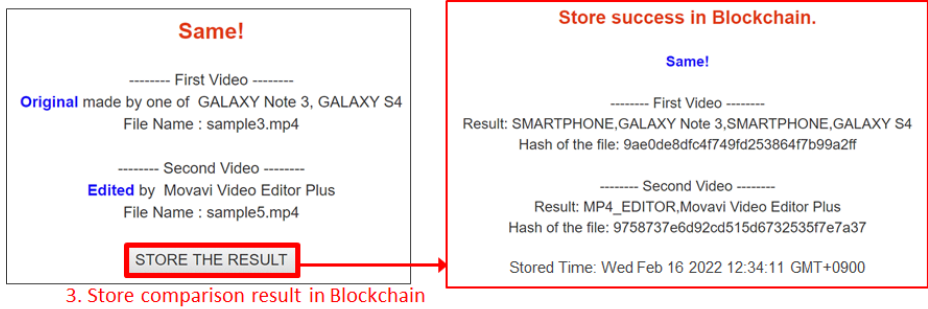
Figure 10. Procedure to store the integrity preservation trace into the blockchain